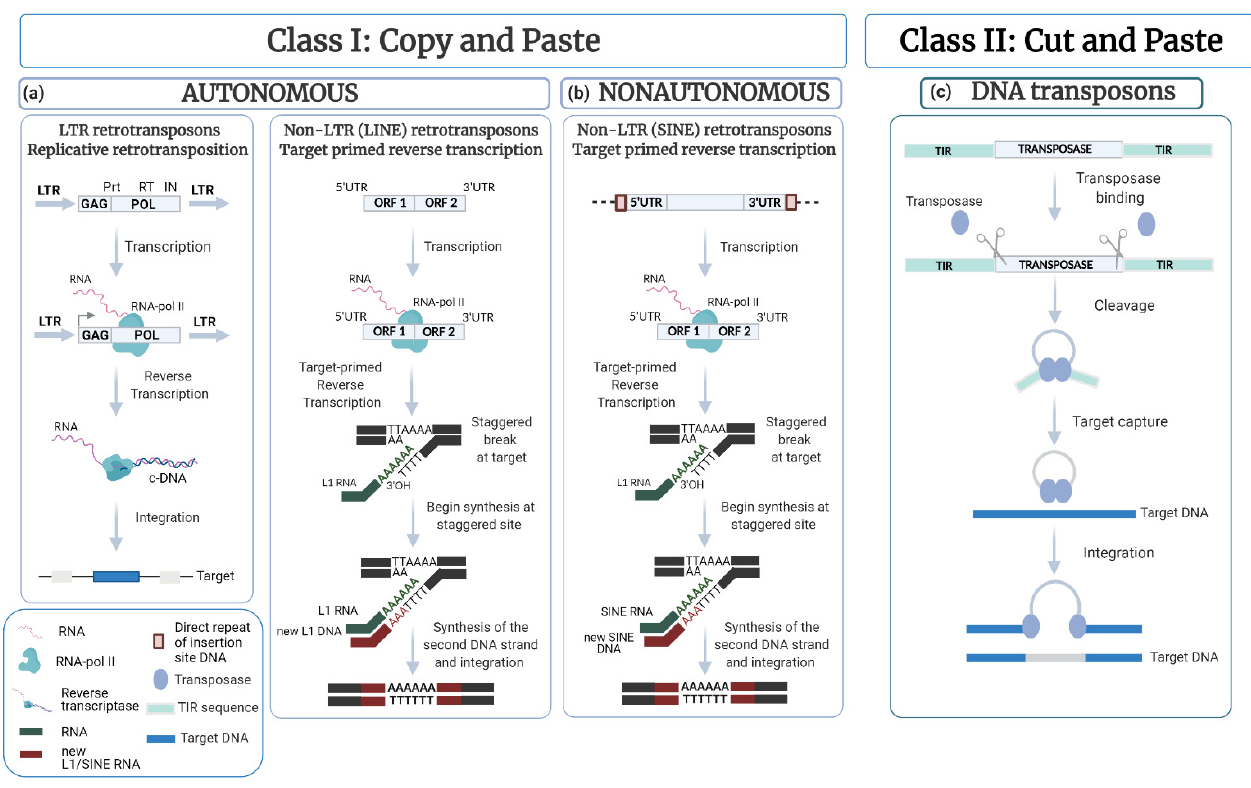
Figure 1. Schematic representation of the different mechanisms of transposition. Generally, TEs can be distinguished in two major classes on the basis of their mechanism of transposition: active eukaryotic Class I (retrotransposons) and active eukaryotic Class II (DNA transposons). Additionally, TEs can be divided into autonomous and non-autonomous. ( a ) Class I (retrotransposons) require RNA transcription to be able to move to different genome locations. They encode for a reverse transcriptase enzyme that uses the transcript as a template to produce a cDNA sequence that reinserts randomly into a new genomic site. This is the so-called “copy and paste” mechanism. Autonomous Class I RNA transposons encode all proteins necessary for moving. They include long terminal repeats/endogenous retroviruses (LTR/ERV; e.g., the yeast Ty element) and non-LTR retrotransposons such as the long interspersed nuclear elements or LINEs (e.g., human L1). LTR-retrotransposons contain two long terminal repeats (LTRs, grey arrows) and genes encoding for functional proteins, such as Gag ( group-specific antigen ), Pol ( reverse transcriptase ), Int ( integrase ) and Prt ( protease ). The non-LTR retrotransposons also contain genes encoding for enzymes required for transposition but lack LTRs. Instead, they have two open reading frames flanked by a 5 ′ and a 3 ′ untranslated region (UTR). Generally, these TEs mobilize by a target-site primed reverse transcription (TPRT) mechanism. After the hydrolysis of one strand of DNA at a new insertion site, the 3 ′ OH end of this strand is used to prime the reverse transcription of a new LINE cDNA by the reverse